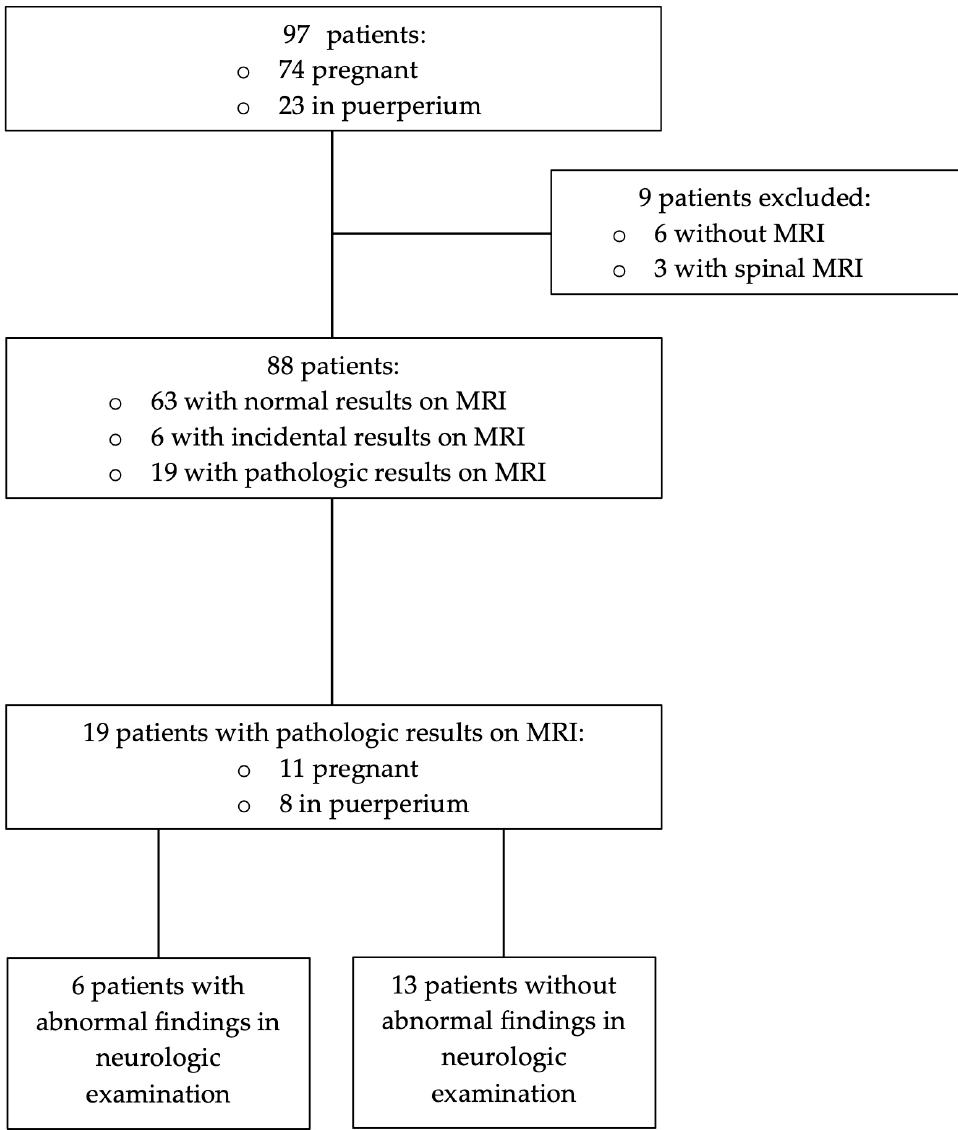
Figure 1. Study population. A total population of 97 patients from the emergency department of the clinic for Gynaecology, Obstetrics and Reproductive Medicine of Saarland University, Homburg, Germany between January 2015 and December 2019 was